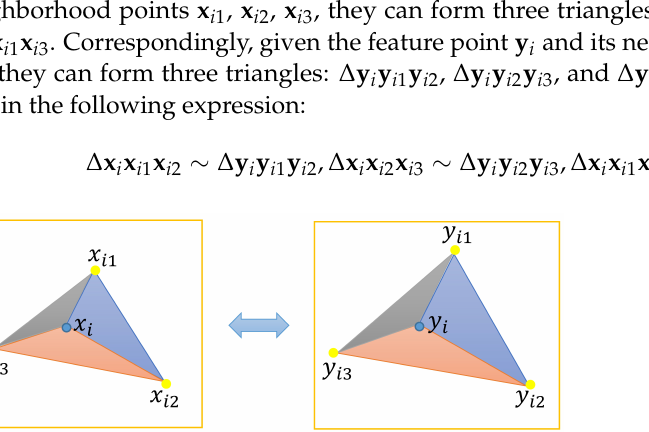
Figure 2. The neighborhood triangle formed by x i and y i and their neighborhood points. The same color indicates the corresponding similar